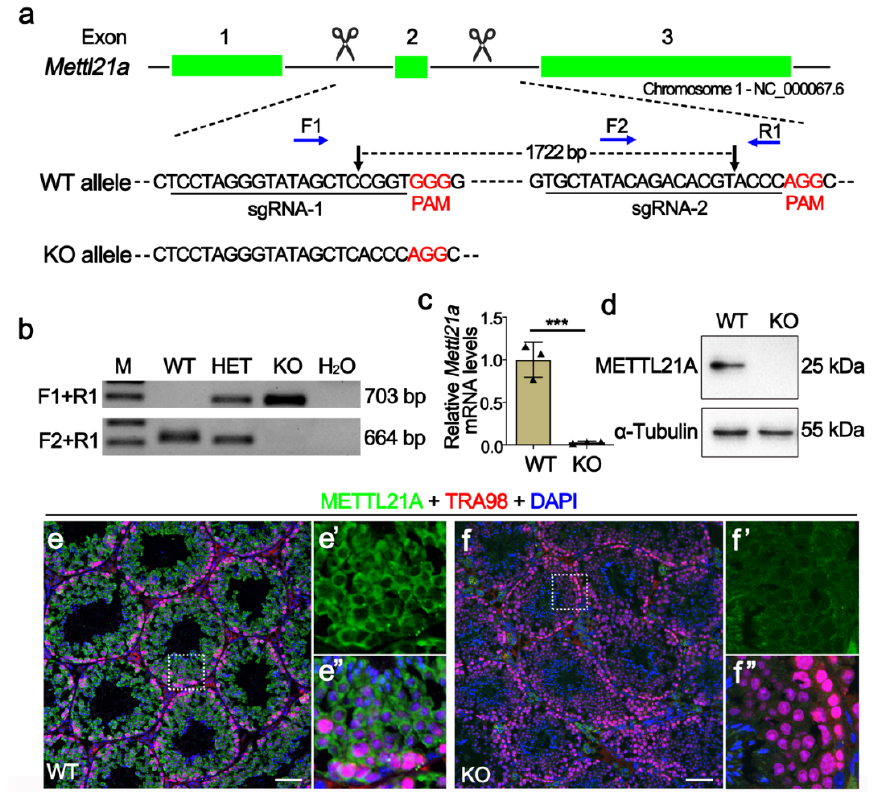
Figure 2. Generation of Mettl21a knockout mice using CRISPR/Cas9 technology. ( a ) Schematic representation of the targeting strategy for generating Mettl21a knockout (KO) mice using the CRISPR/Cas9 system. Green boxes represent exons of the Mettl21a gene on mouse chromosome 1; black underlines indicate the target regions of sgRNAs and black arrows show the cut sites, blue arrows indicate the sites of forward (F) and reverse (R) primers for genotyping. ( b ) Representative PCR genotyping results of Mettl21a alleles show that the WT allele is a longer band (703bp) using F1 and R1 primers, and the mutant allele is a shorter band (664bp) using F1 and R2 primers. M, marker; Het, heterozygous; H 2 O, negative control. ( c ) RT ‐ qPCR analyses of Mettl21a mRNA levels in P56 WT and KO testes. Data are presented as mean ± SEM, n = 3. *** p < 0.001 by student’s t ‐ test. ( d ) Western blot showing the METTL21A protein levels in WT and KO testes at P56. α‐ Tubulin served as a loading control. ( e – f’’ ) Co ‐ immunofluorescence staining of METTL21A and TRA98 (a nuclear marker of pan ‐ germ cells) in WT and KO mouse testicular sections. Nuclei were stained with DAPI. Scale bars = 50 μ m. Magnified images ( e’ , e’’ , f’ , f’’ ) of white boxes in ( e ) and ( f ), further highlight the changes in METTL21A localization and expression between WT and KO testes.